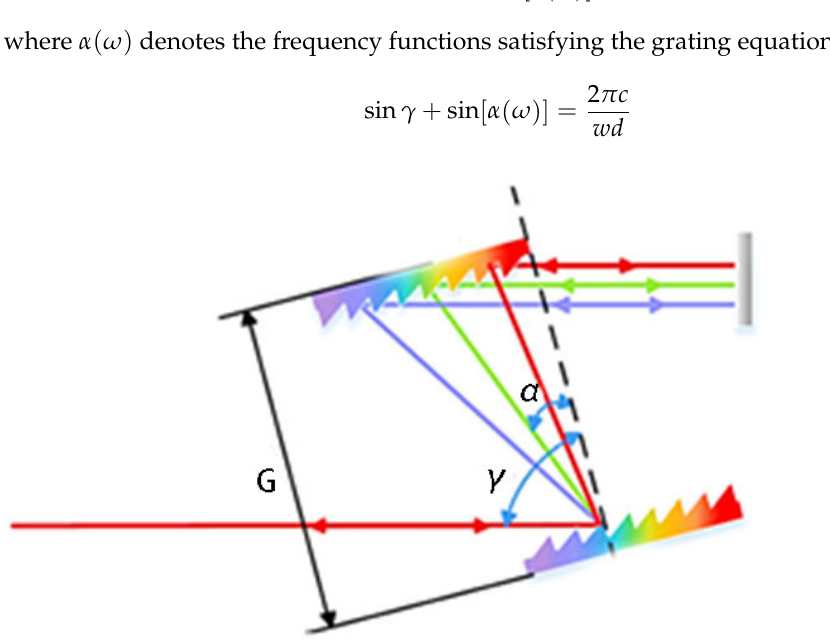
Figure 1. Principle diagram of dispersion induced by parallel grating pairs.